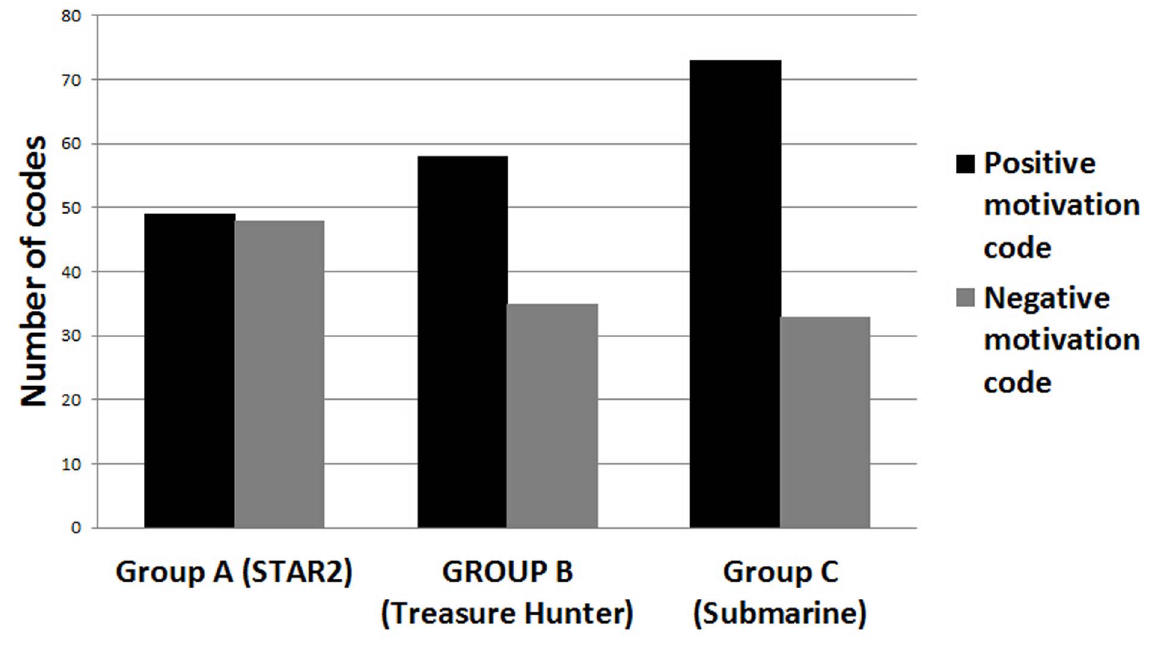
Figure 3. Frequency of codes related to intrinsic motivation. Data were extracted from 55 interviews in total (n=18 for STAR2 , 18 for Treasure Hunter , and 19 for Submarine ).